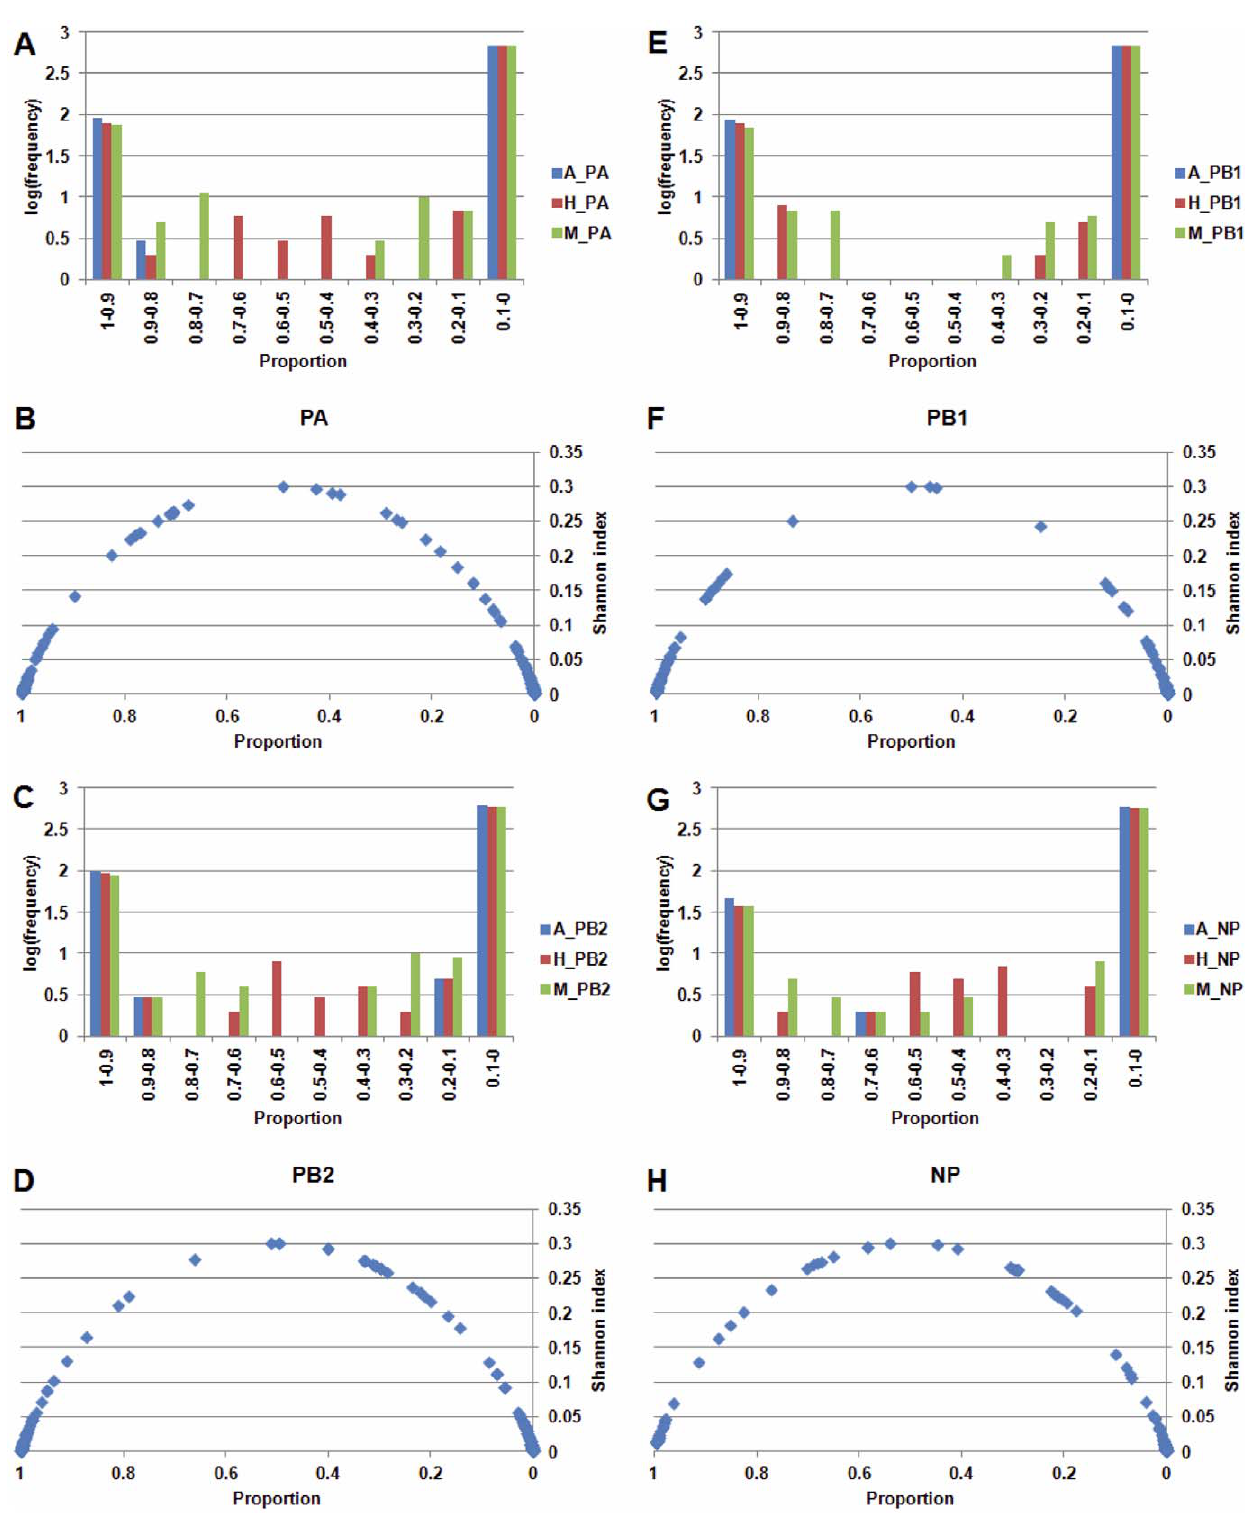
Figure 1. The distribution of occurrence and the Shannon diversity index of SLiMs in IAV RNPs. For A, C, E and G the Y-axis indicates the number of identified SLiMs, and the X-axis indicates the occurrence of the SLiMs. For B, D, F and H the Y-axis indicates the Shannon diversity index. The X-axis indicates the occurrences of SLiMs. The occurrence of a SLiM at an aa position is computed by the number of the RNP sequences with the SLiM at the same position divided by total number of the RNP sequences. (A) The frequency distribution of the identified SLiMs in the PA protein sequences. (B) The Shannon diversity index distribution of the identified SLiMs in the PA protein sequences. (C) The frequency distribution of the identified SLiMs in the PB1 protein sequences. (D) The Shannon diversity index distribution of the identified SLiMs in the PB1 protein sequences. (E) The frequency distribution of the identified SLiMs in the PB2 protein sequences. (F) The Shannon diversity index distribution of the identified SLiMs in